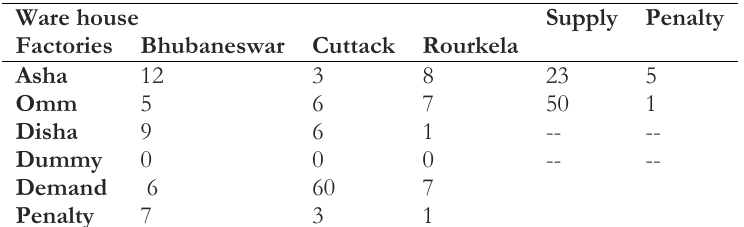
Table 7. 3 rd Penalties